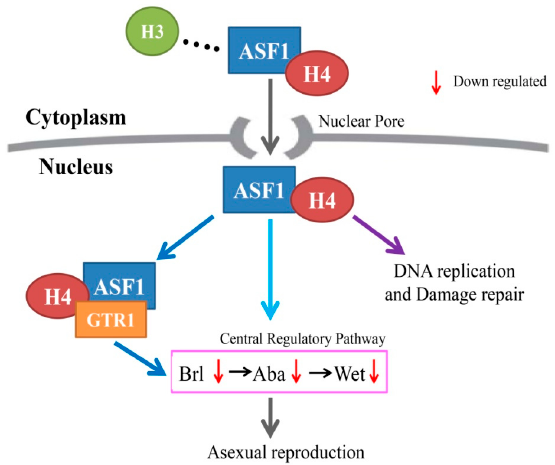
Figure 6. A model for ASF1 binding H4 (ASF1-H4) to interact with GTR1 and then to mediate asexual reproduction in Stemphylium eturmiunum . ASF1 interacts with H4 and then they are translocated into nuclei through the nuclear pore. The dimer of ASF1-H4 regulates DNA replication and damage repair in previous studies. Herein, ASF1-H4 combines with GTR1 to constitute a trimeric complex which in turn is involved in the central regulatory pathway to modulate asexual repro- duction.